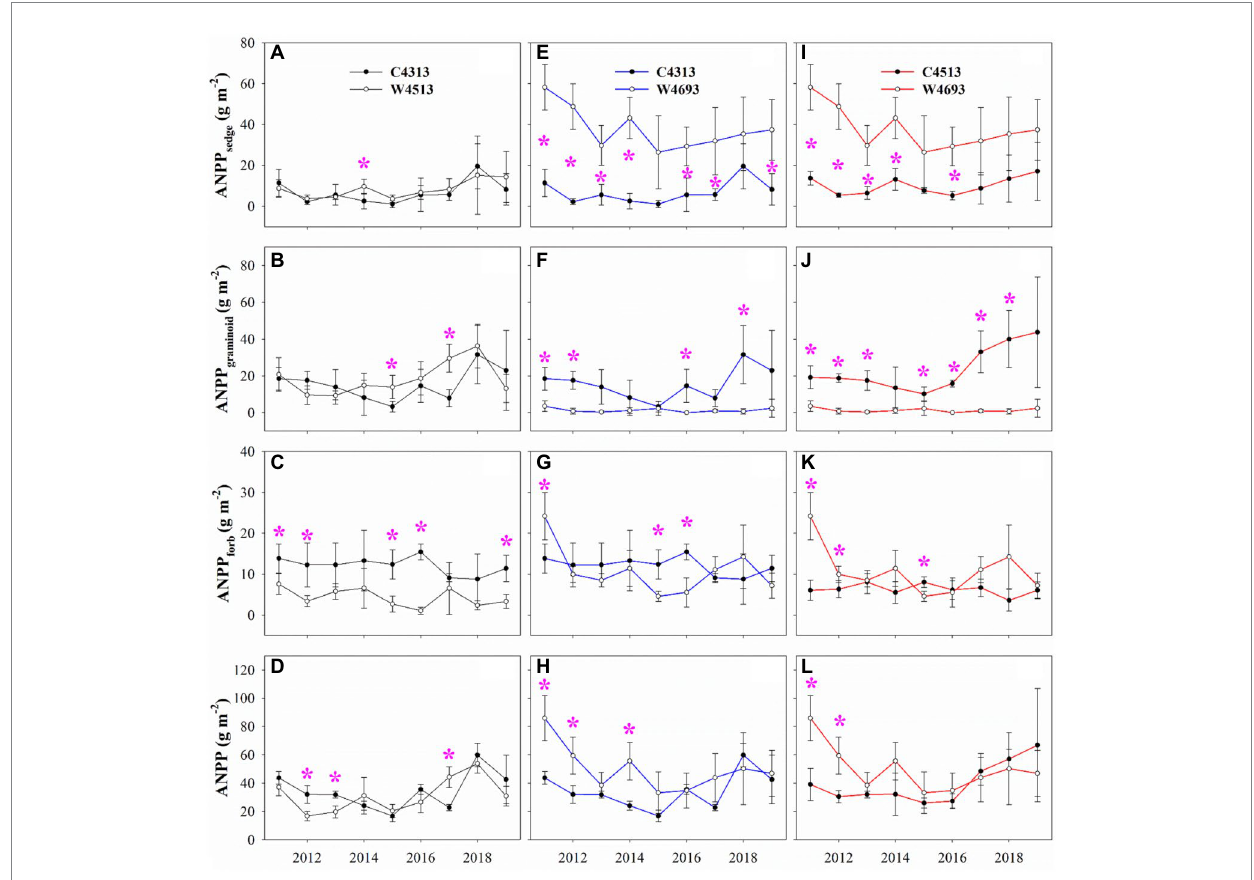
FIGURE 2 Comparison of aboveground net primary production of plant community (ANPP), aboveground net primary production of sedge (ANPP sedge ), aboveground net primary production of graminoid (ANPP graminoid ), and aboveground net primary production of forb (ANPP forb ; A–D ) between the non- warming plots at elevation 4,313 m (C4313) and warming plots at elevation 4,513 m (W4513), (E–H) between the C4313 and warming plots at elevation 4,693 m (W4693), and (I–L) between the non-warming plots at elevation 4,513 m (C4513) and the